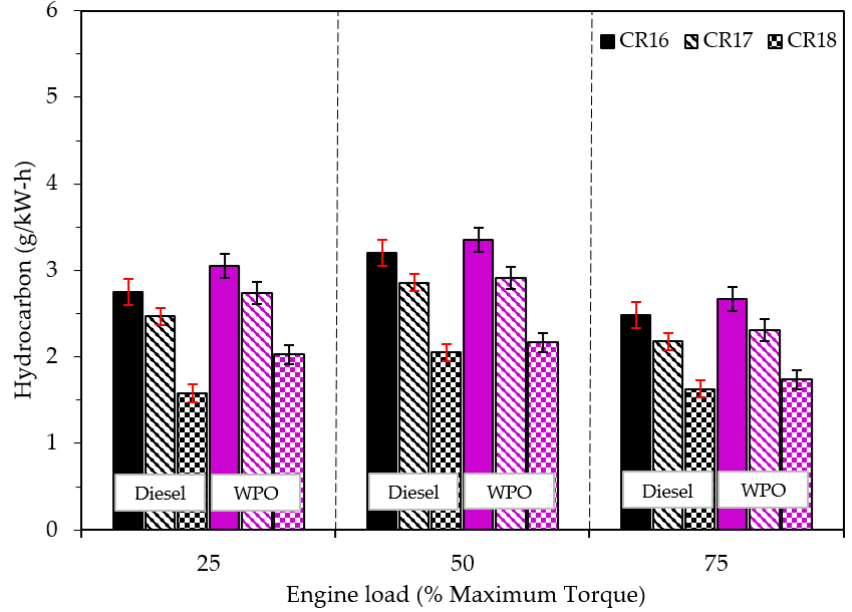
Figure 10. Variation in the unburned hydrocarbon (HC) emissions with engine loads.